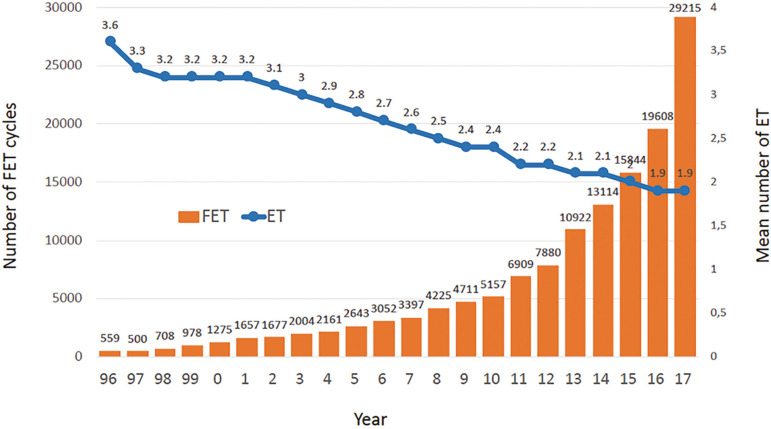
Trends in the number of frozen/thawed embryo transfer (FET) cycles and mean number of embryos transferred (ET). Latin America, 1996-2017